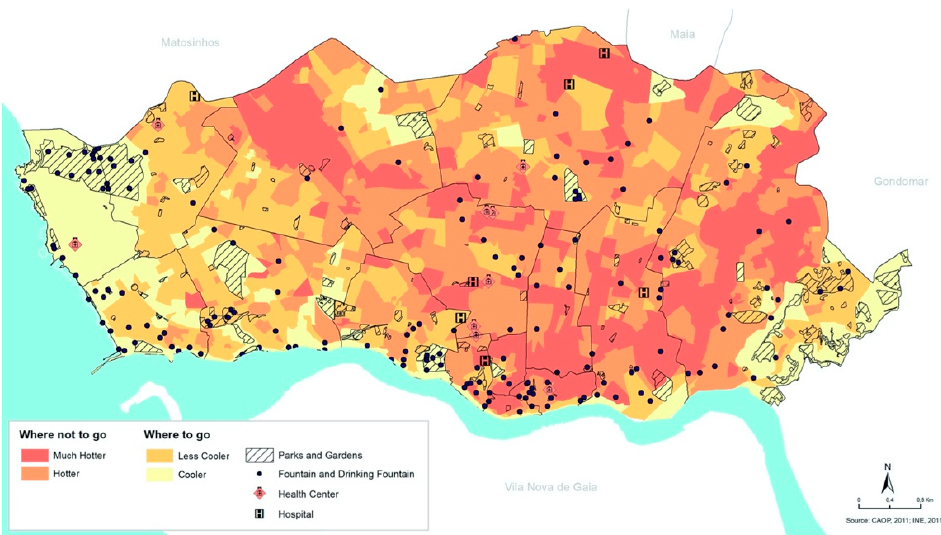
Figure 4. Risks and potential solutions on extremely hot days (surface temperature delivered by Landsat 8, band 10 satellite image).